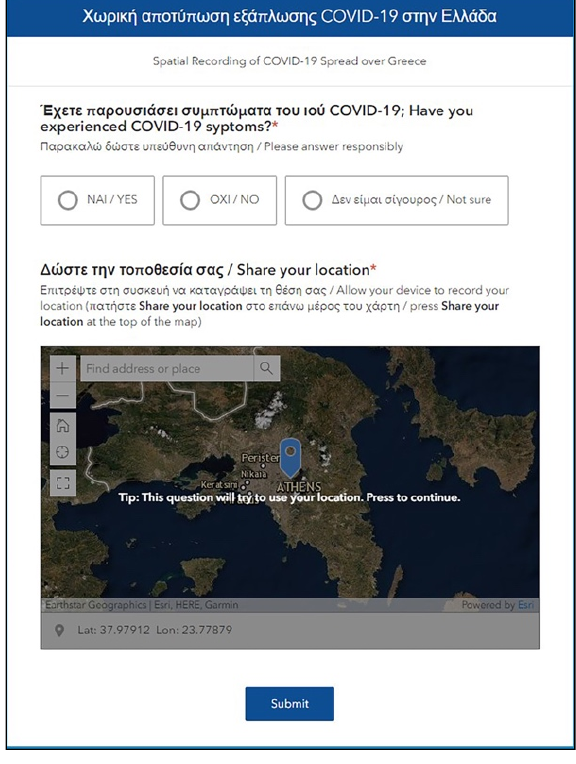
Figure 1. Interface of the survey in Greek and English (https://arcg.is/1yiXG4).